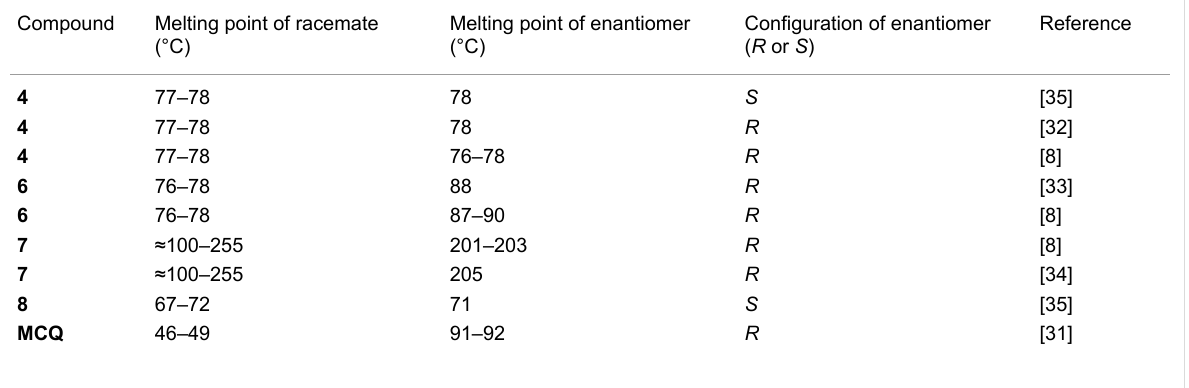
Table 1: Values of melting points of synthesized racemic camphor derivatives and corresponding pure enantiomers ( R or S ) from the literature.